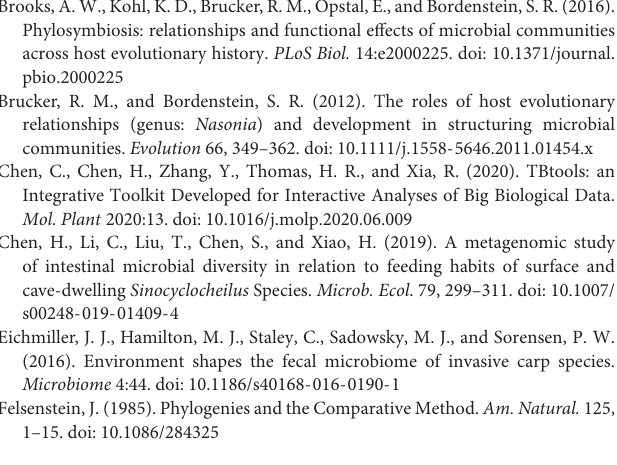
Supplementary Figure 3 | LDA Effect Size (LEfSe) method to find out microbiota biomarkers between four Phylogenetic clades. Supplementary Figure 4 | The phylogenetic independent contrasts between standard eye diameter (sED) and gut microbial alpha diversity index. Supplementary Figure 5 | Analysis of similarities (Anosim) test based on Bray–Curtis distance for wild group and captive group. Supplementary Figure 6 | LDA Effect Size (LEfSe) method to find out microbiota biomarkers in wild and captive cavefish. Supplementary Figure 7 | The biodiversity of gut microbiota in species from the four phylogenetic clades after captivity. Supplementary Figure 8 | Ten shared ASVs among 22 species of Sinocyclocheilus . Supplementary Figure 9 | Comparison of alpha diversity indices of Sinocyclocheilus ( N = 17) before and after captivity. Supplementary Table 1 | Sample collection information form. Supplementary Table 2 | ASV table, Taxonomic annotation, and metadata table of wild samples. Supplementary Table 3 | ANOVA, Tukey HSD test of phylogenetic clades. Supplementary Table 4 | ASV table, Taxonomic annotation and metadata table of water and fish microbiota. Supplementary Table 5 | Water chemistry with the results of its analysis. Supplementary Table 6 | ASV table, Taxonomic annotation and metadata table of Captive population. Supplementary Table 7 | Changes in the bacterial assemblages from wild to captivity. (A) ANOVA, Tukey HSD test of wild and captive groups; (B) overlapped 426 ASVs in Wild and Captive populations; (C) relative abundance of the two groups at the Phylum level; (D) differential abundance of ASVs between Wild and Captive populations.